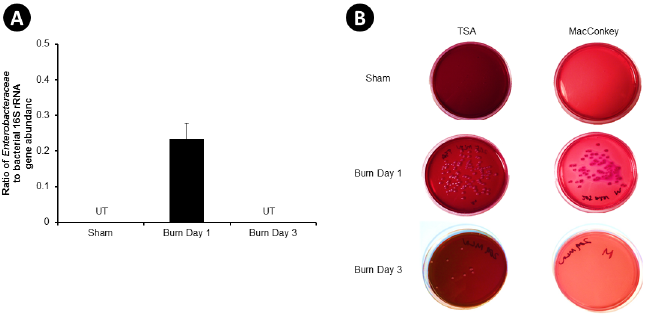
Fig 4. Bacterial Abundance in the Mesenteric Lymph Nodes (MLN) of Mice. MLN were aseptically removed from sham, burn day 1, and burn day 3 animals and Enterobacteriaceae were quantified by qPCR and standardized by total bacterial 16s rRNA gene abundance, ( A ). Data were expressed as mean ± SEM of 5 – 11 animals per group. Enterobacteriaceae abundance from sham and burn day 3 animals were all not detectable (ND). In addition, MLN homogenates were plated on Tryptic Soy Agar with 5% sheep blood and MacConkey Agar plates and cultured aerobically for 24 hours with 5% CO 2. ( B ) is a representative image of plates produced from one